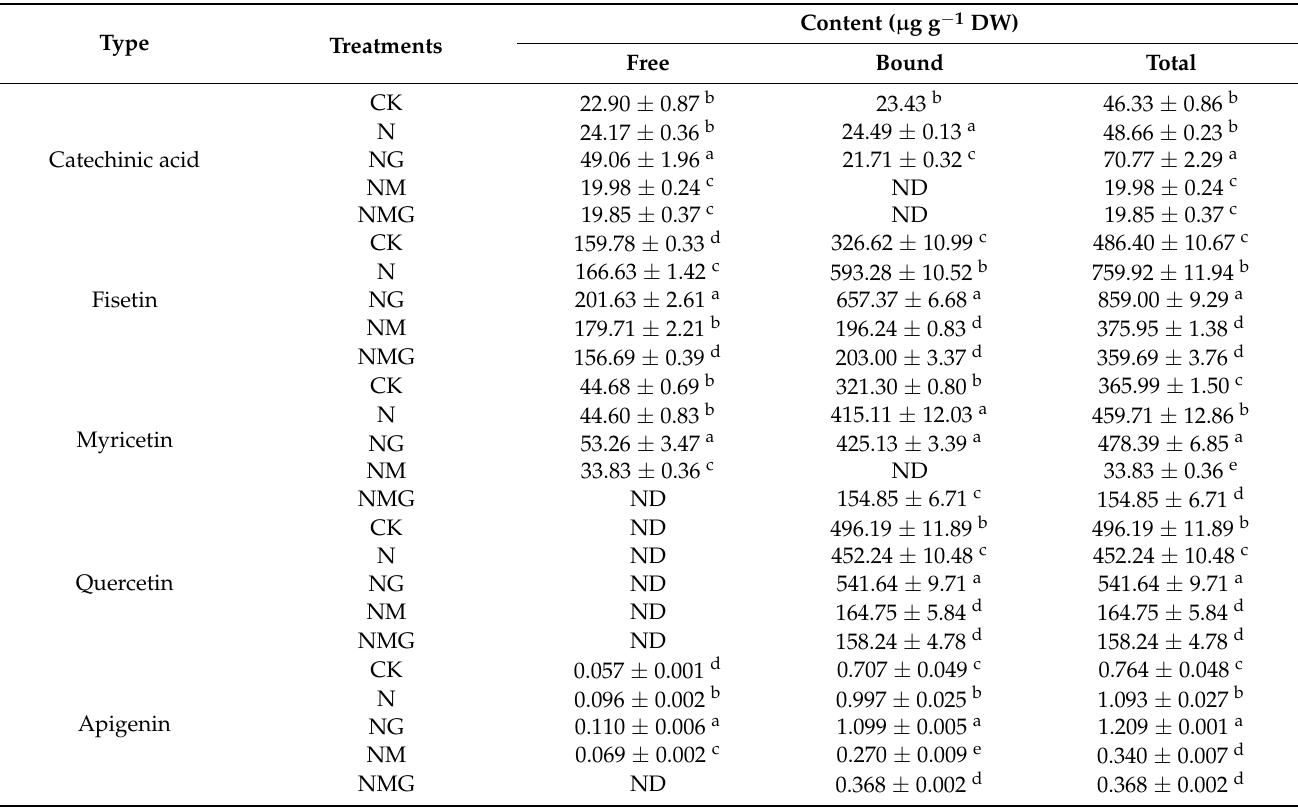
Table 3. The individual flavonoid content in barley